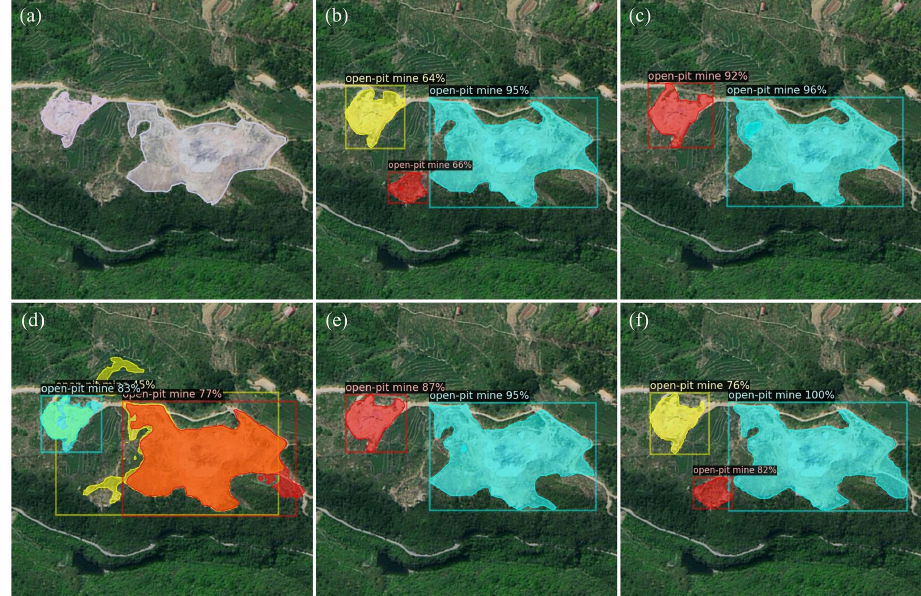
Figure 9. Model inference probabilities and shapes on Tianditu image. ( a ) Ground truth of quartz mines. ( b ) Inference result by BlendMask model; ( c ) inference result by BlendMask-VoV model; ( d ) inference result by CondInst model; ( e ) inference result by CondInst-VoV model; ( f ) inference result by Mask R-CNN